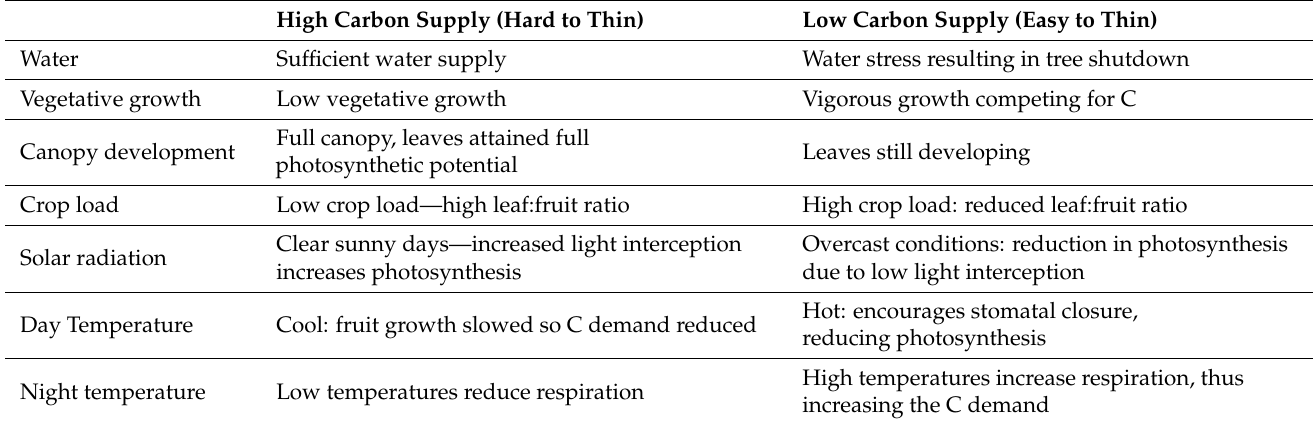
Table 13. Factors affecting the tree carbon balance during fruit development. Source: Bound